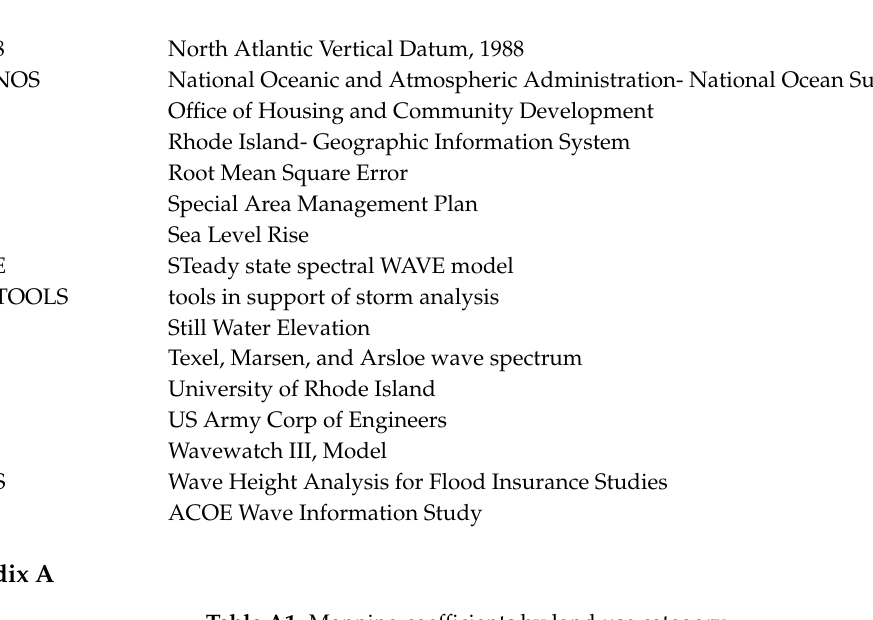
Table A1. Manning coefficients by land use